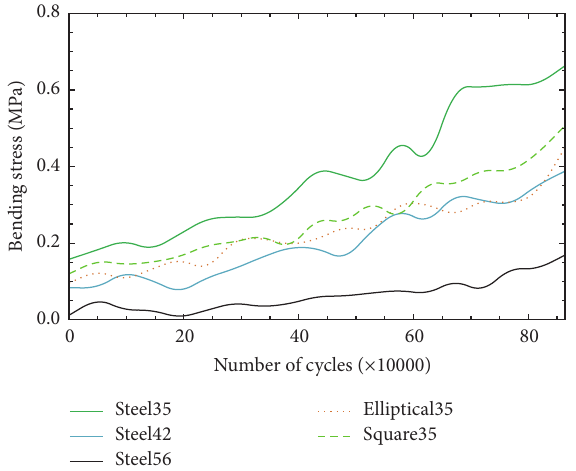
Figure 14: Back-calculated bearing